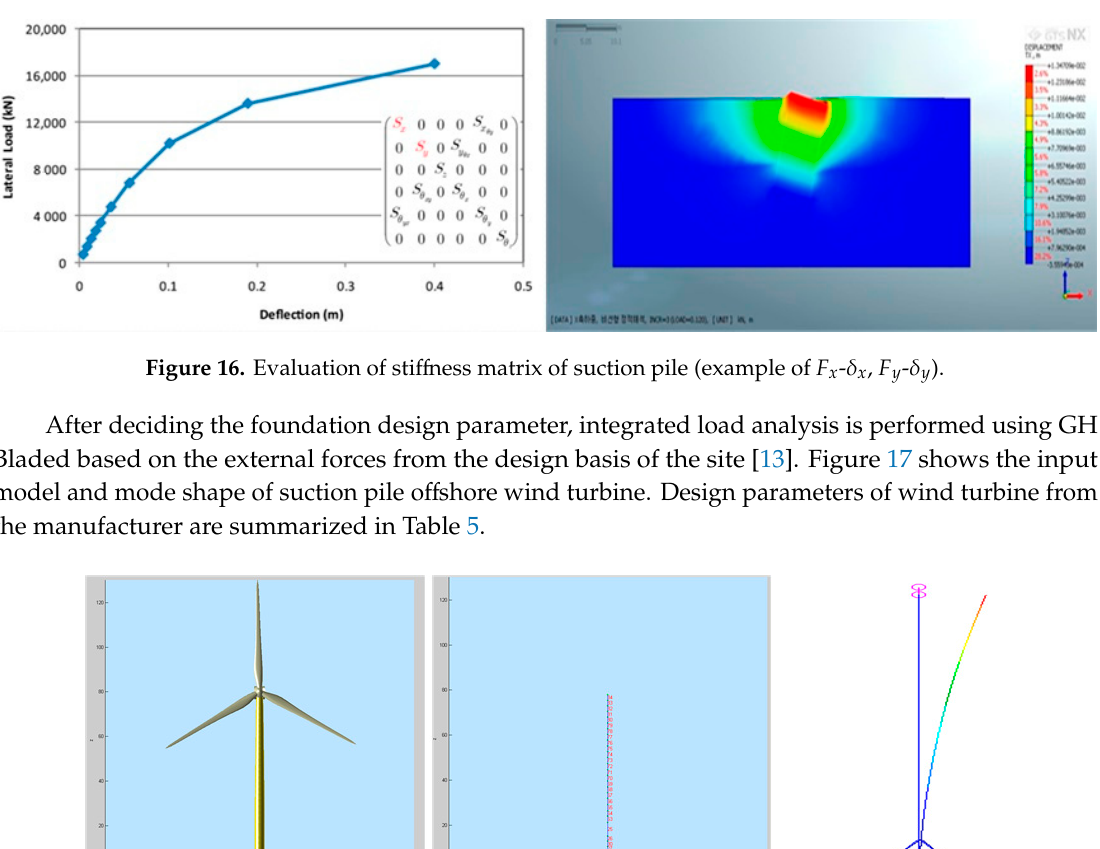
Table 5. Design load case parameters.